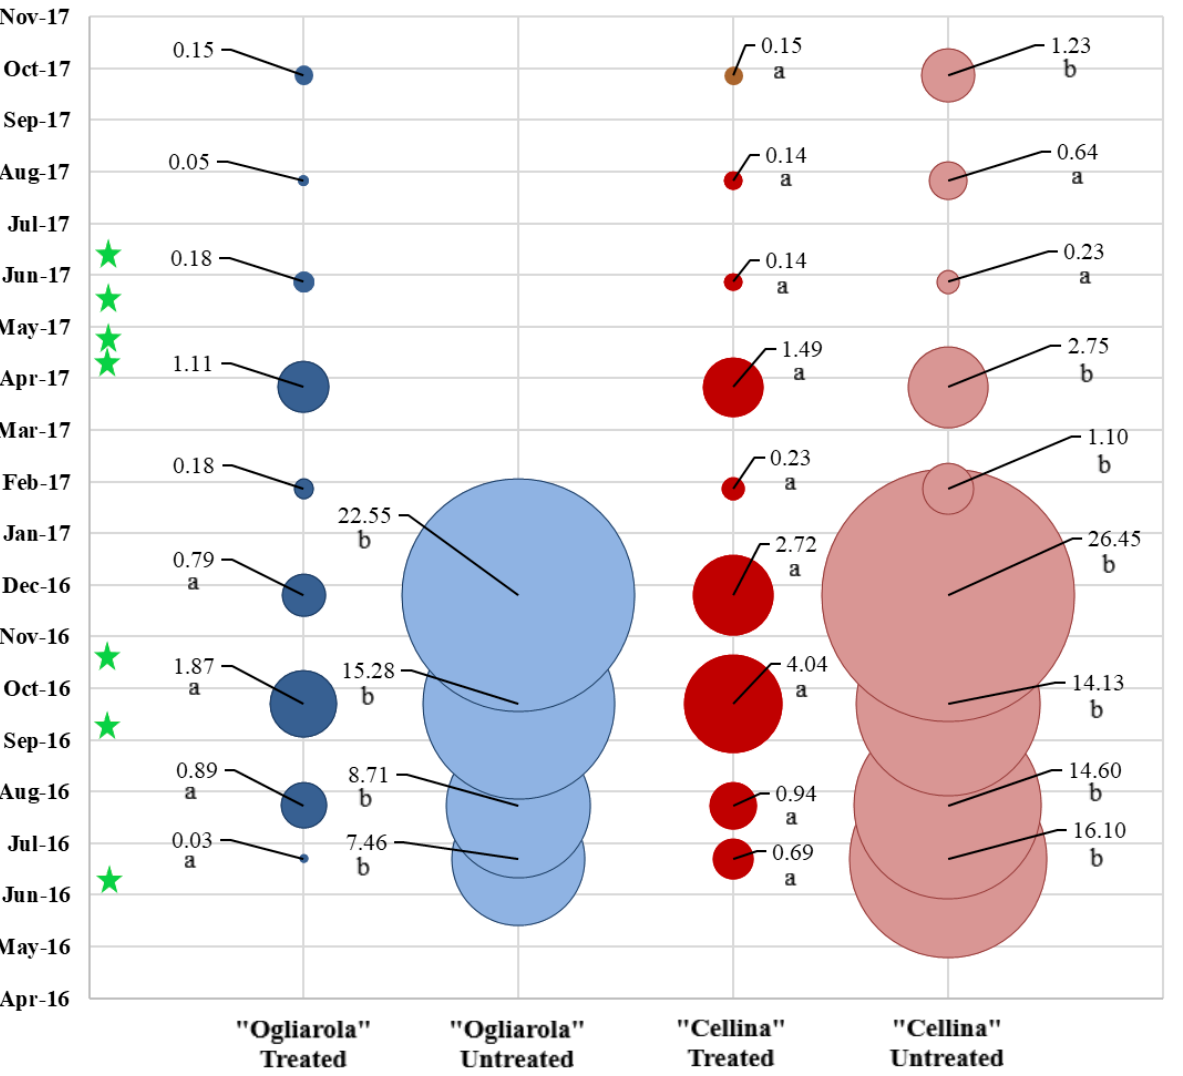
Figure 7. Xylella fastidiosa subsp. pauca DNA concentration detected in olive trees at each sampling, and expressed as mean ng DNA per tree, determined using the methods of Modesti et al . (2017), and obtained from June 2016 to September 2017 in the olive orchard of Veglie (Lecce province) planted with cv. Ogliarola salentina and Cellina di Nardò. Statistical significance was evaluated at P <0.05. Different letters indicate significance of the treatment. Asterisk refers to the day of Dentamet® treatment in the treated block. Note the reduction of X. fastidiosa DNA after the frost events of January 2017. The cv. Ogliarola salentina untreated control tree died in December 2016, whereas the cv. Cellina di Nardò untreated con - trol tree became almost completely withered on April 2017, so that samples were taken from the remaining live canopy without respecting sampling